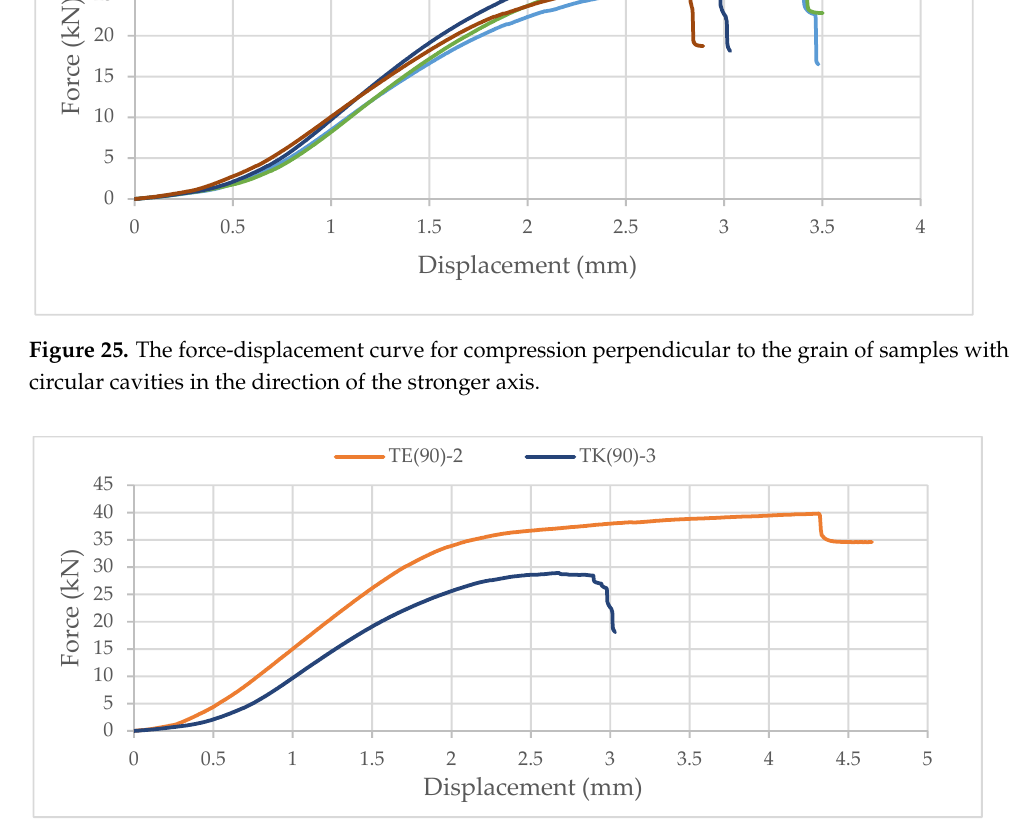
Figure 26. Comparison of the force-displacement curve for compression perpendicular to the grain of samples with elliptical and circular cavities in the direction of the stronger axis.